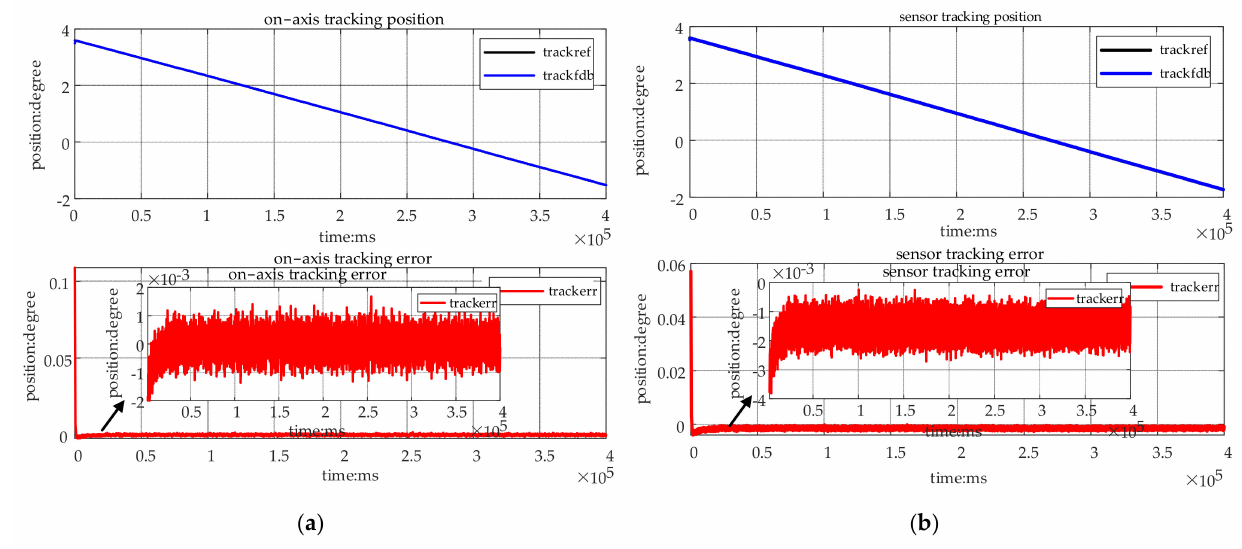
Figure 12. ( a ) Closed-loop tracking position curve for on-axis tracking; ( b ) tracking position curve for offset position